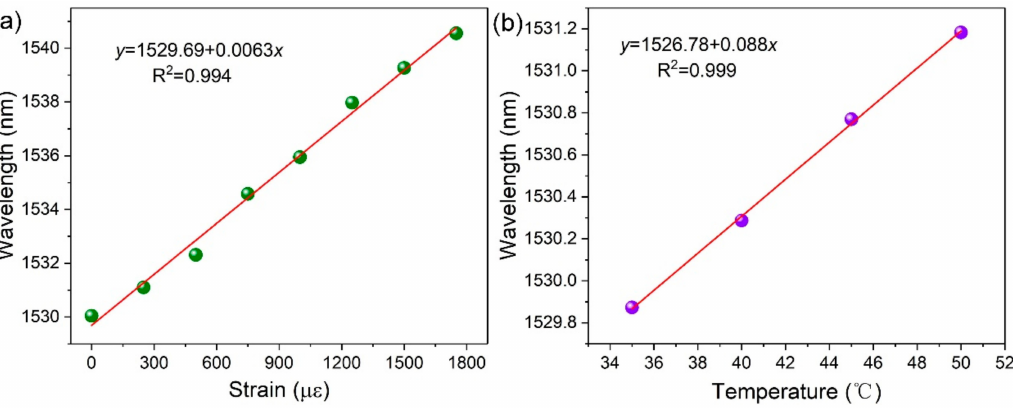
Figure 4. The Bragg resonance wavelength responses linearly to ( a ) strain and ( b )